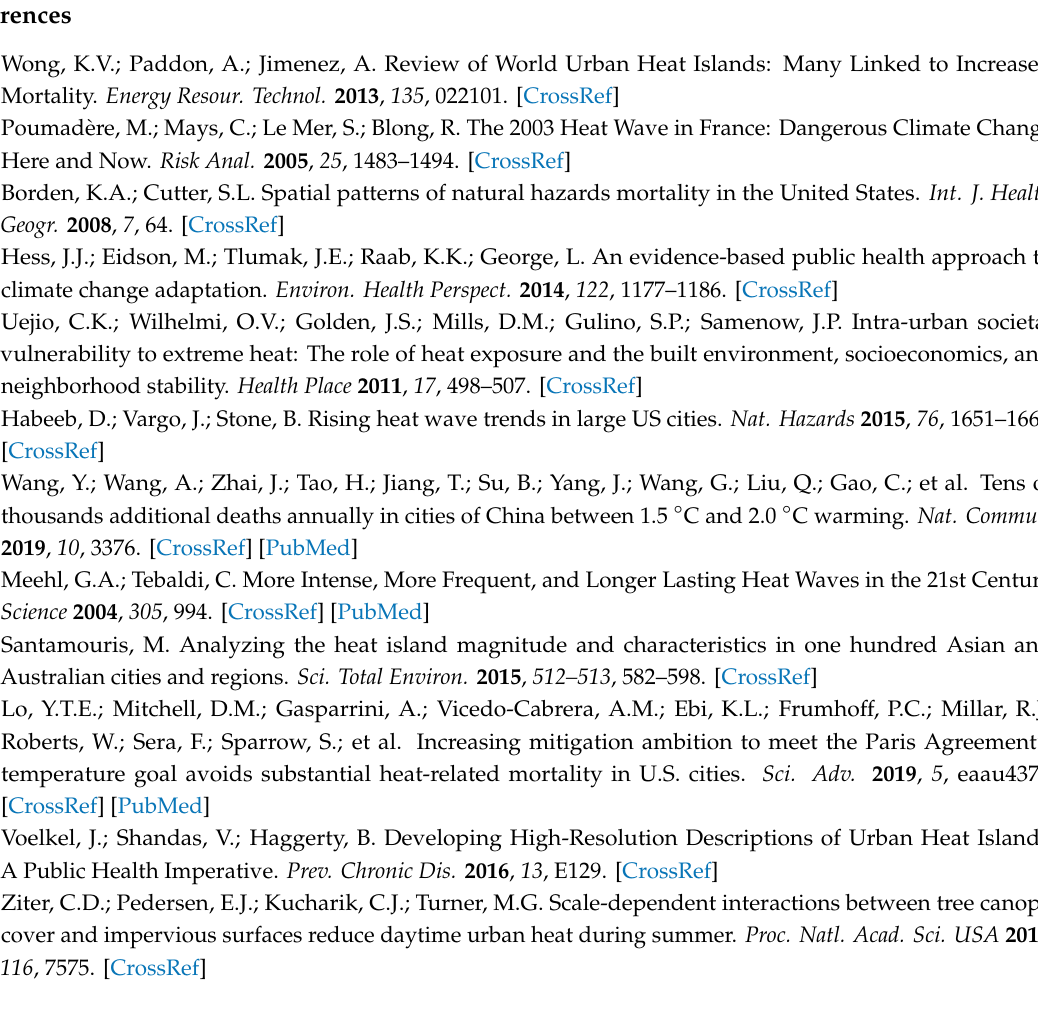
Figure S1: Comparison of urban areas of relatively large or small di ff erences in LSTs between HOLC grades, Table S1: Urban area-specific results from our LST